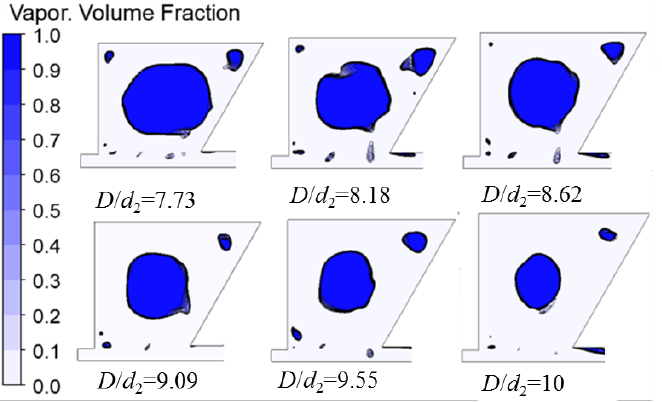
Figure 14. Steam pocket regions of the nozzle with different cavity diameters.